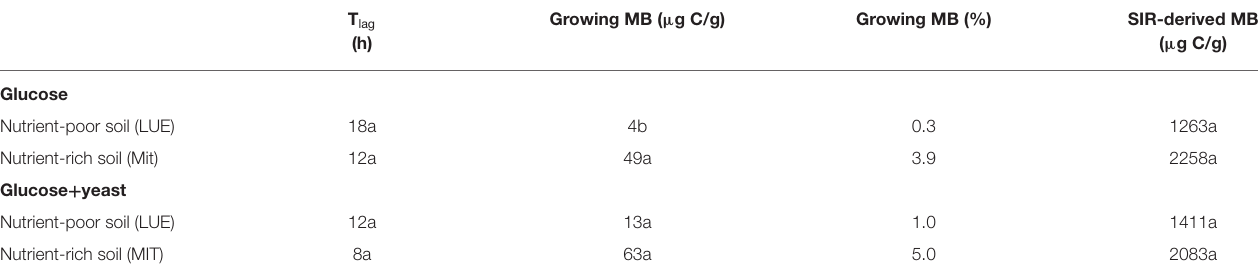
TABLE 2 | Microbial growth respiration parameters, such as lag phase (T lag ), actively growing microbial biomass (MB) according to Panikov (1995) and substrate-induced respiration derived microbial biomass content after Anderson and Domsch (1986) including the conversion factor used by Kaiser et al. (1992).